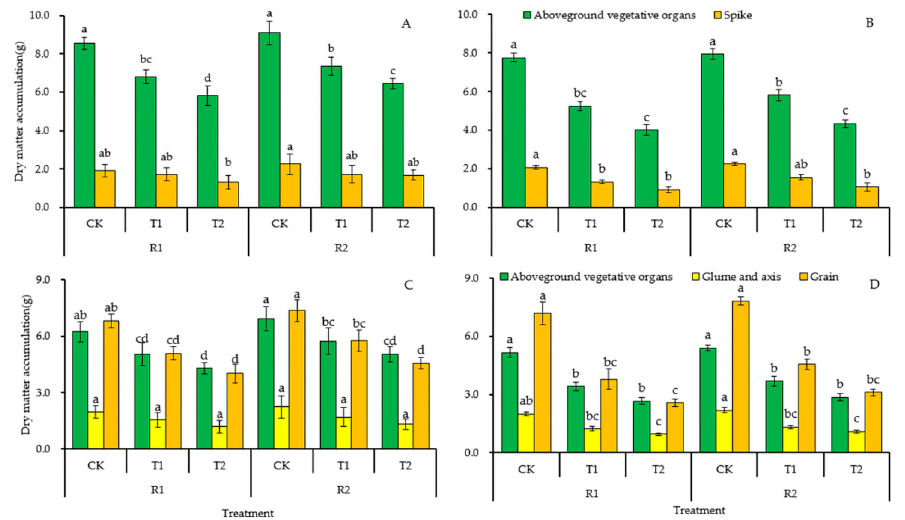
Figure 3. Effects of OPA on dry matter accumulation in different wheat organs under low-temperature stress at different growth stages. ( A ) Different organs dry matter accumulation of Yannong19 at the flowering stage. ( B ) Different organs dry matter accumulation of Xinmai26 at the flowering stage. ( C ) Different organs dry matter accumulation of Yannong19 at the maturity stage. ( D ) Different organs dry matter accumulation of Xinmai26 at the maturity stage. Data represent mean ± SE ( n = 3). Different letters following the data within each column indicate significant differences at p < 0.05 . Aboveground vegetative organs: leaves + stems + sheaths. R1 and R2 represent traditional phosphorus application and optimized phosphorus application, respectively. CK, T1, and T2 represent 11 °C, 4 °C and − 4 °C, respectively.